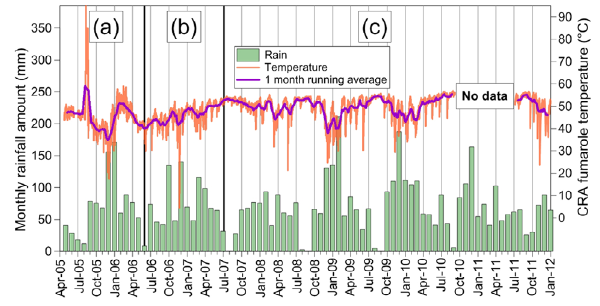
Figure 5. Top: hourly temperature (orange line) measured at 30 cm depth at CRA station and its 1 month-running average (purple thick line); bottom: monthly rainfall amounts (green bars). (a), (b) and (c) indicate the three phases in which the studied period was subdi- vided (see text for details). Data refers to the period from April 2005 to December